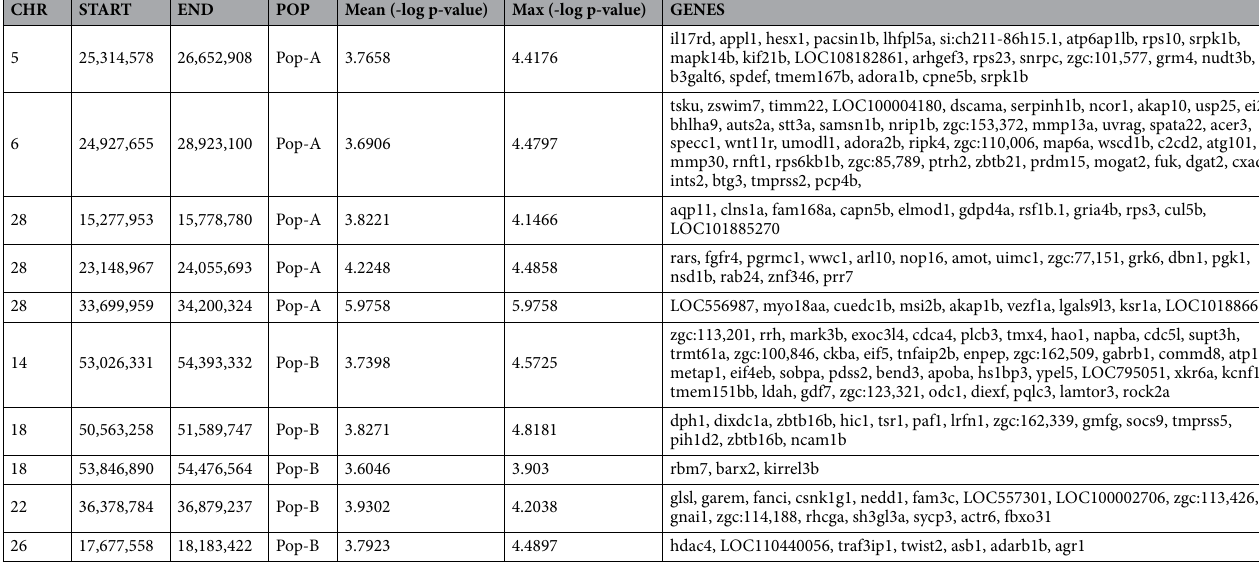
Table 1. Genomic regions and genes spanning the five strongest detected selection signatures by iHS in each population.